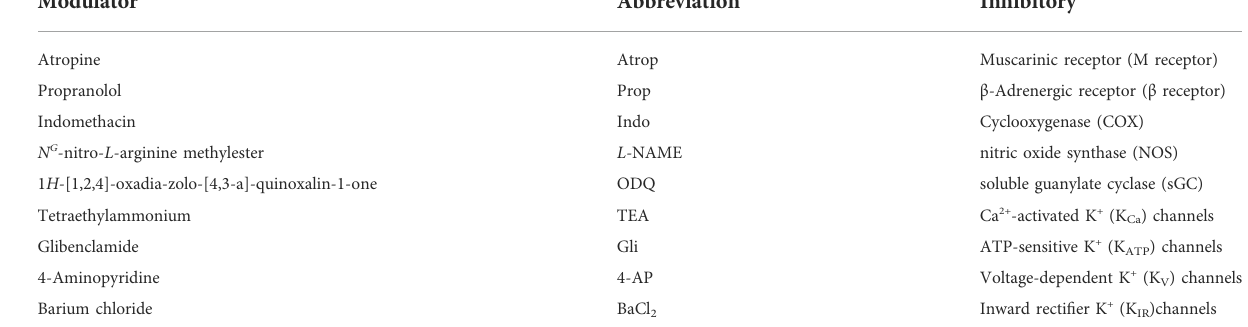
TABLE 3 Modulators used for the vasorelaxative effect.